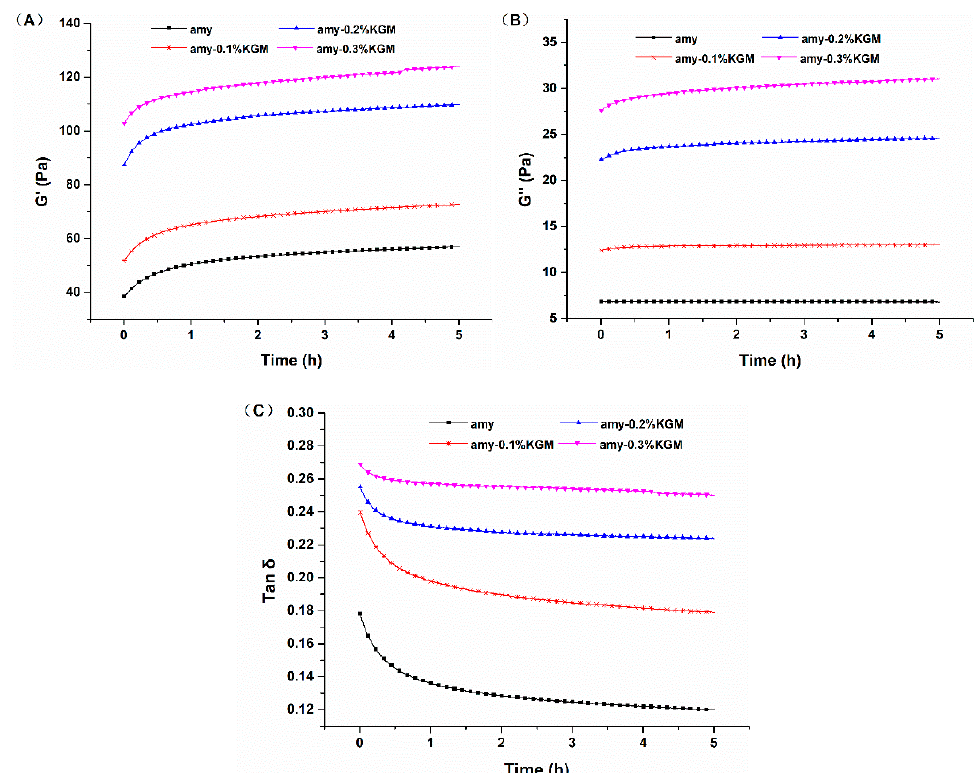
Figure 2. Time sweeping curves of G’ ( A ), G” ( B ), and Tan δ ( C ) of amylose–KGM mixtures.